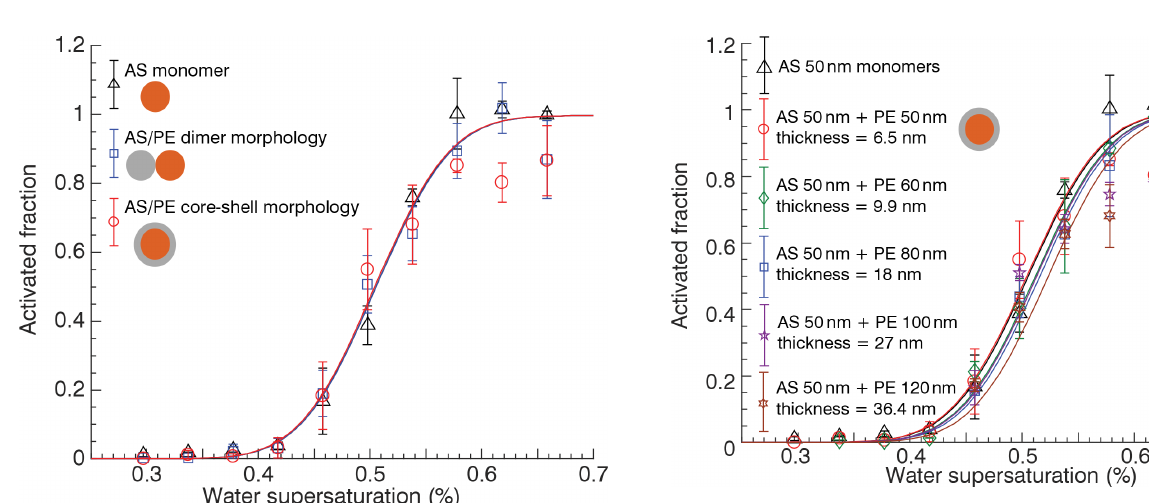
Figure 4. Activated fraction determined at mode diameter of ammonium sulfate monomers and mixed ammonium sul- fate / polyethylene particles with dumbbell and core-shell mor- phologies at different water supersaturation. Lines correspond to a fit to the data.